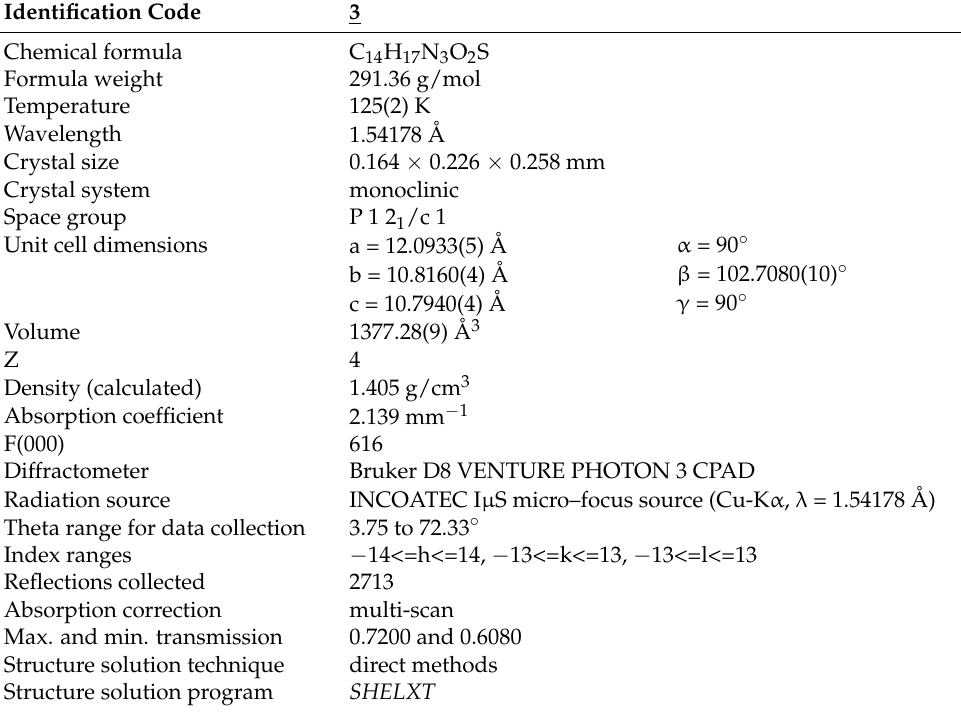
Table 4. Crystal and refinement data for 3